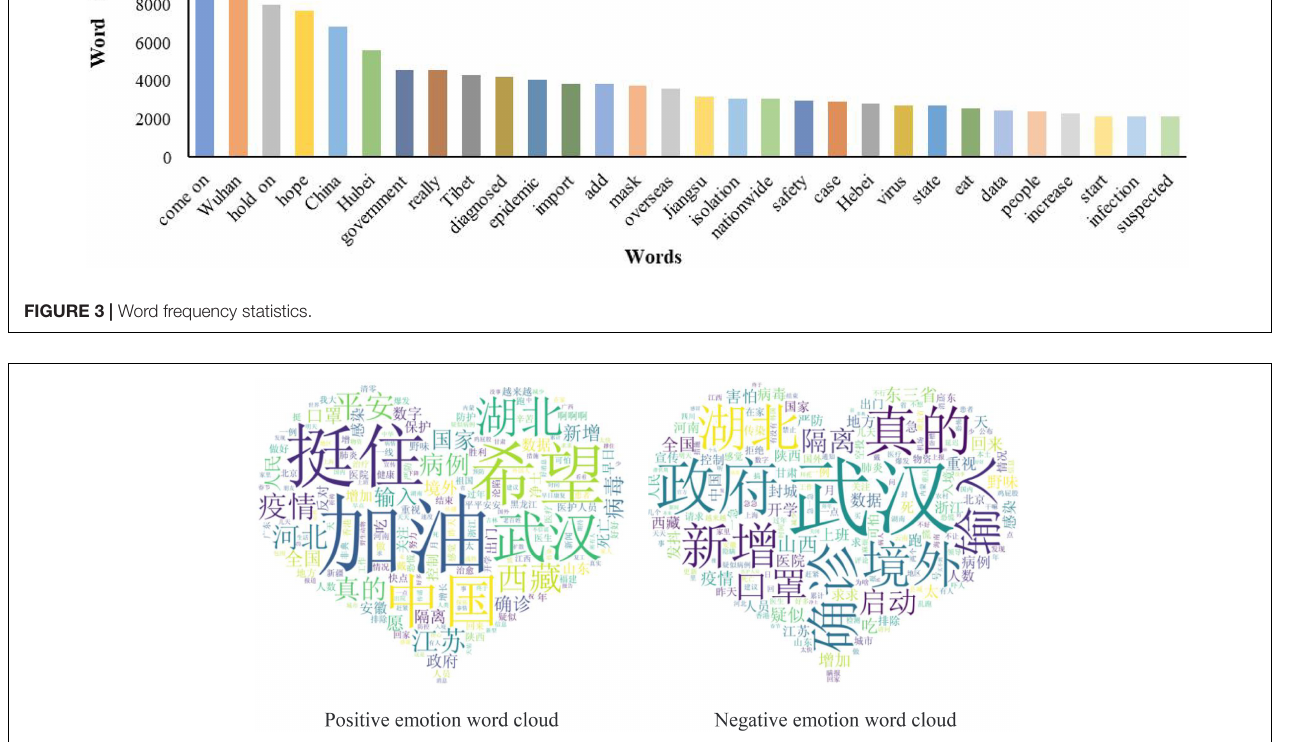
FIGURE 4 | Word cloud of positive and negative